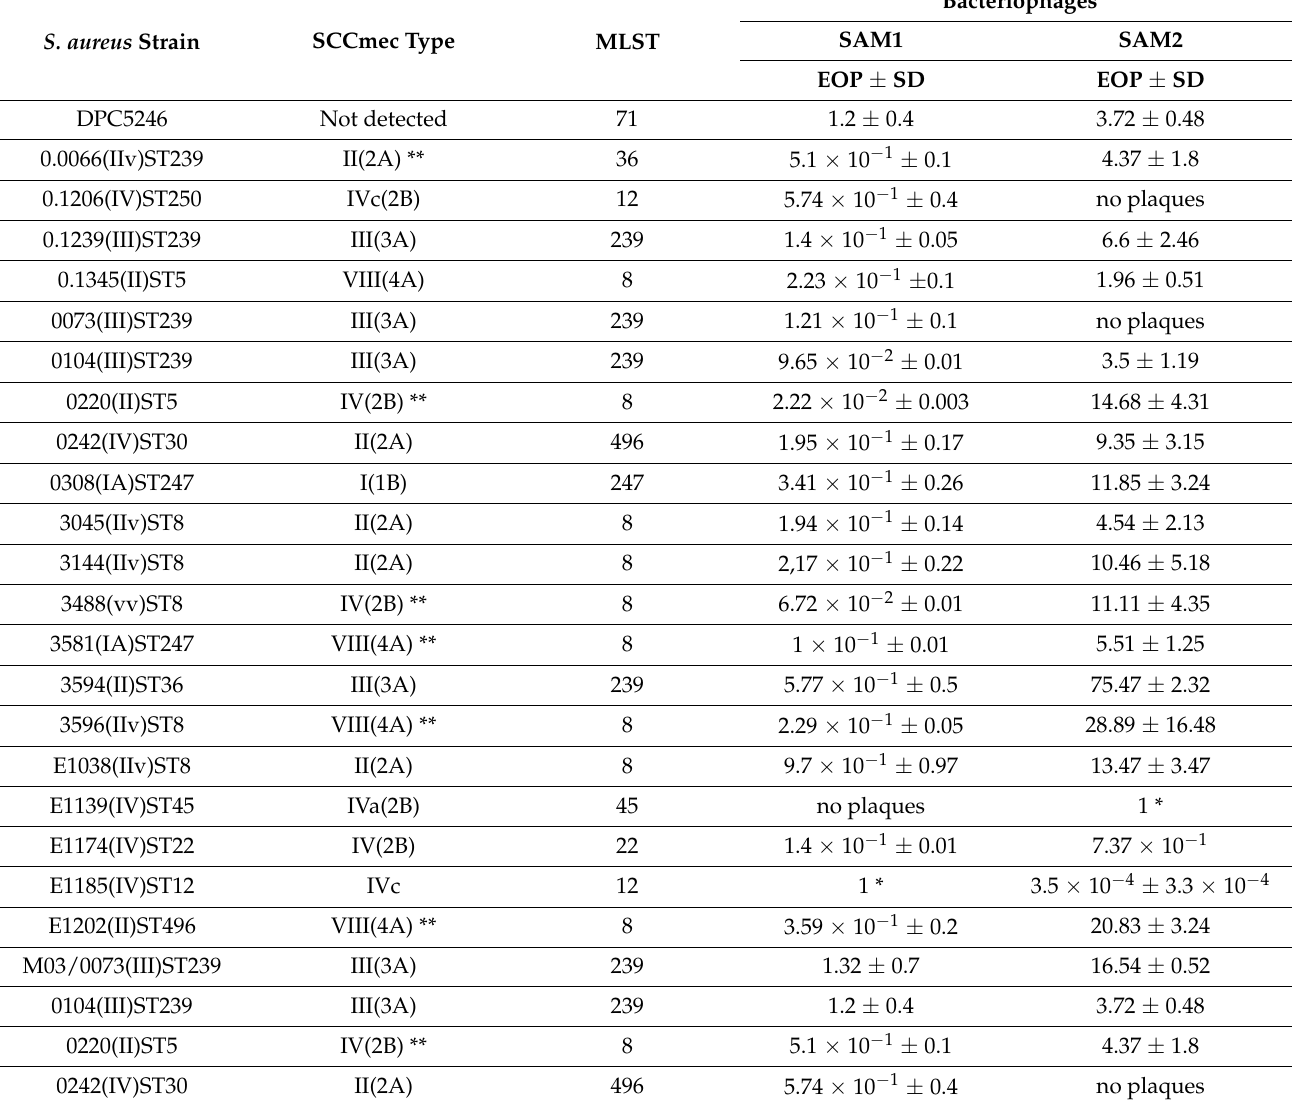
Table 1. Host ranges of staphylococcal phages SAM1 and SAM2 on 22 Staphylococcus aureus strains, comprising of 21 MRSAs of differing sequence types obtained from the Irish National MRSA collection and DPC5246, the propagating host of phage K. The table documents the efficiency of plaquing (EOP)